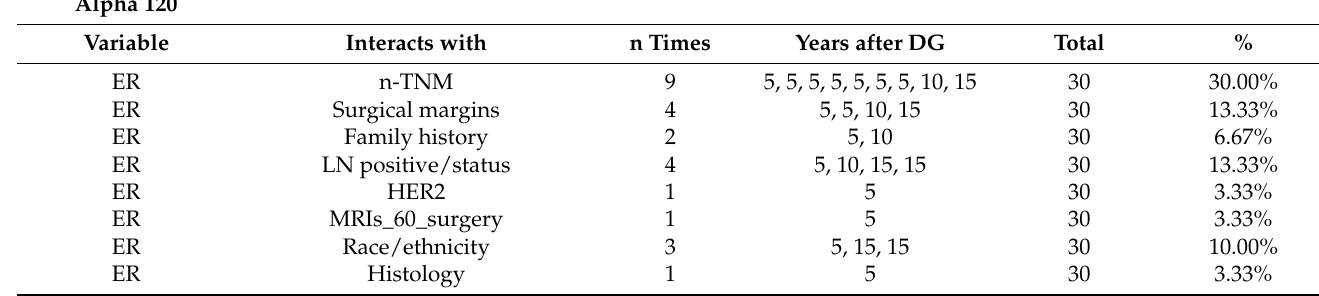
Table 3. Variables interacting with an alpha of 120. ER, TNEG, HER2, race/ethnicity and alco- hol/smoking are represented with their interacting variables, the number of times they interacted, the years after diagnosis when these interactions were found to be risk factors for metastases, the total number of times the variables interacted and frequency of